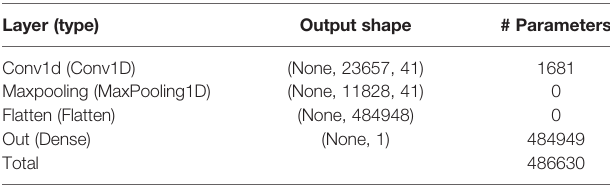
TABLE 3 | Layer name and type, output data shape of the layer, and number of trainable parameters per layer for the model with the Bayesian optimized model averaged hyperparameters using the pig EBV